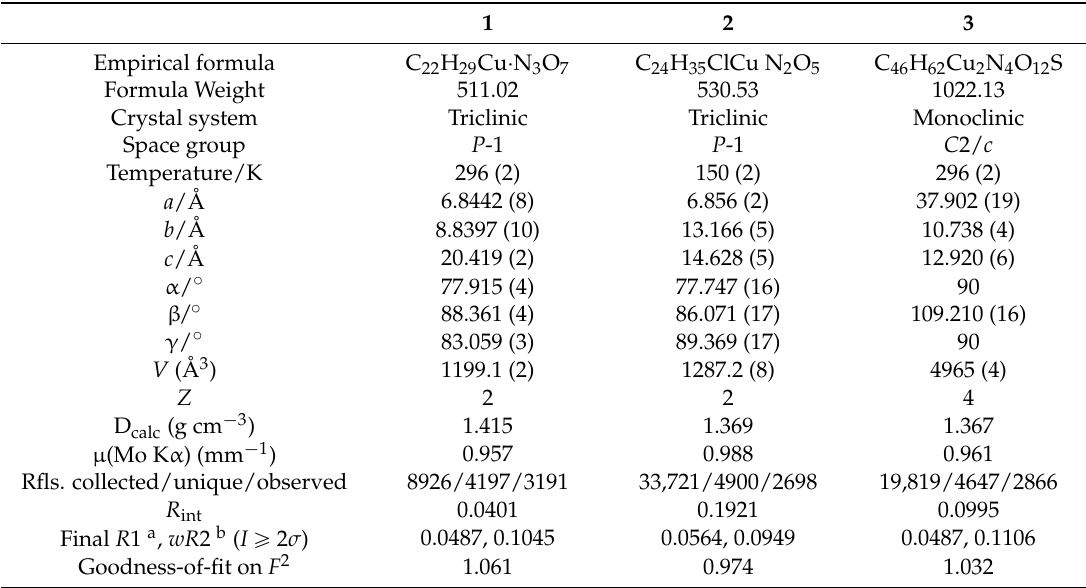
Table 1. Crystal data and structure refinement details for complexes 1 – 3 .